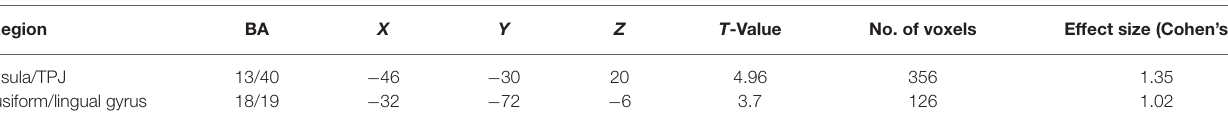
TABLE 2 | Overview of fMRI